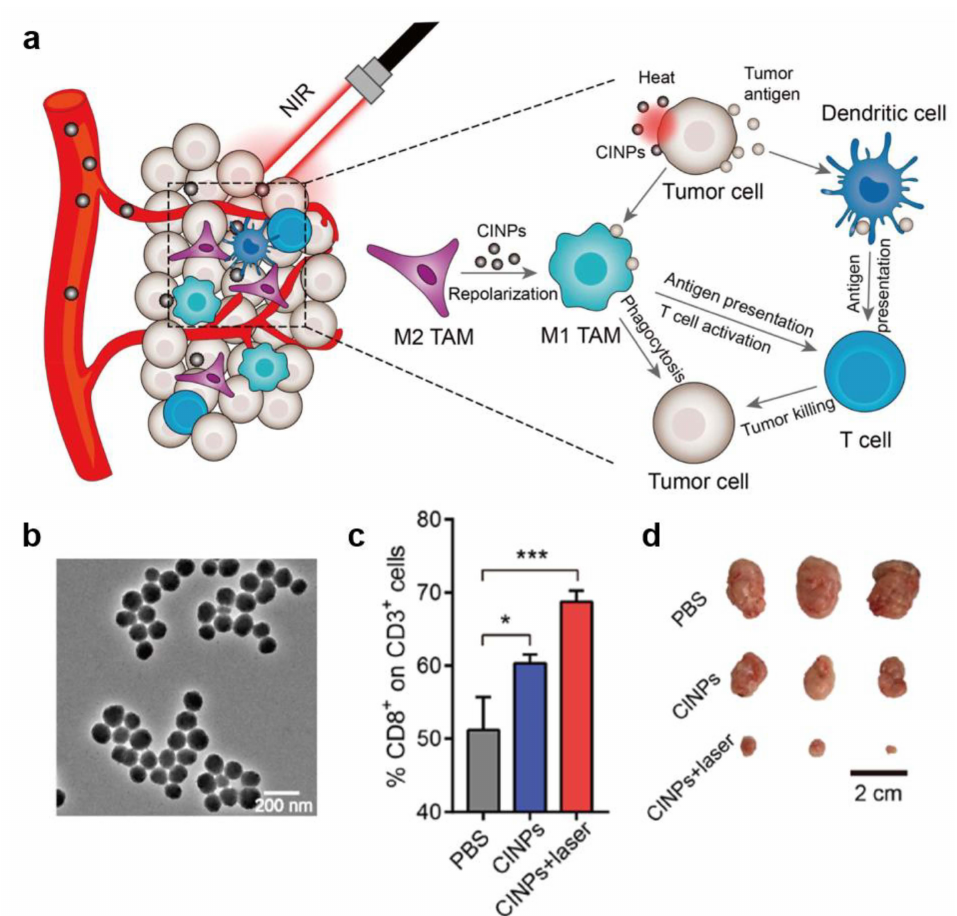
Figure 12. Nanoparticles from cuttlefish ink for inhibiting tumor growth by inducing macrophage repolarization and synergizing photothermal therapy. ( a ) Schematic illustration of anti-tumor mechanism of CINPs in vivo. ( b ) TEM images of CINPs. ( c ) Relative quantification of CD8 + T cells in CD3 + T cells within tumors following different treatments. ( d ) Representative tumor images of different groups after 16 days’ treatment [33]. Data are presented as the mean ± SD ( n ≥ 3). * p < 0.05, *** p < 0.001. Int. J. Mol. Sci. 2020 , 21 , x FOR PEER REVIEW